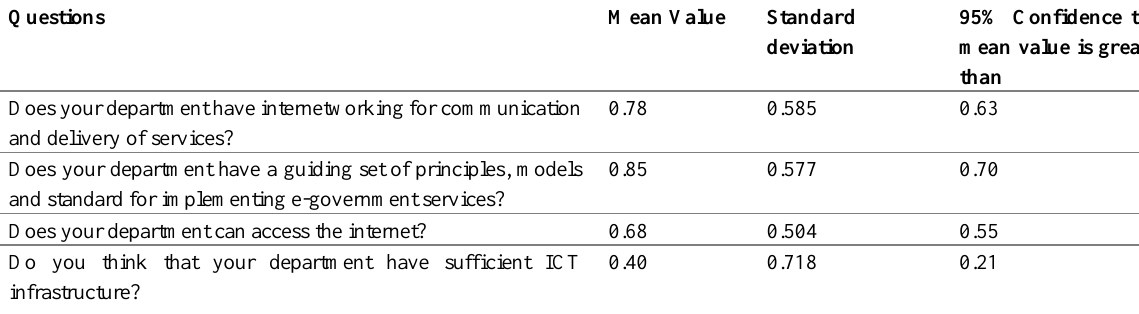
Table 8: Results of Questionnaire Processing Related to Ict Infrastructure